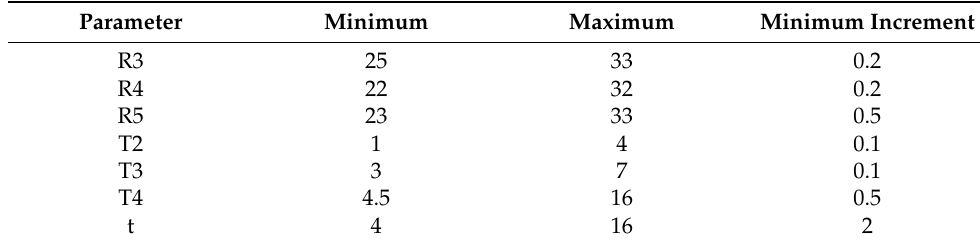
Table 3. Search space parameters for the chosen topology.